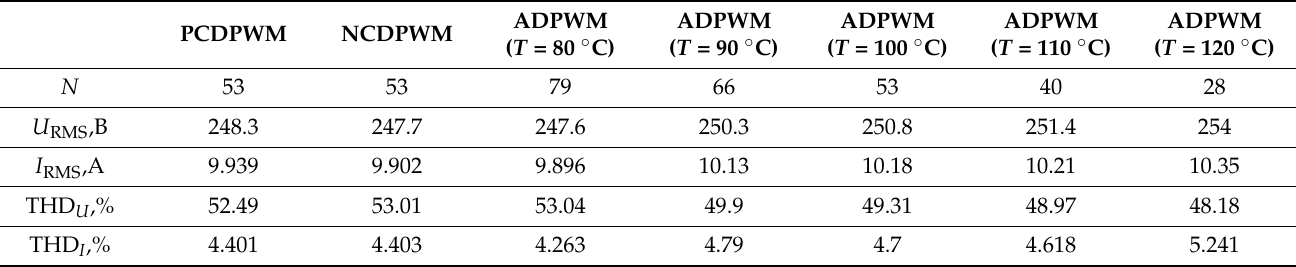
Table 7. Simulation results at MI = 1.0.